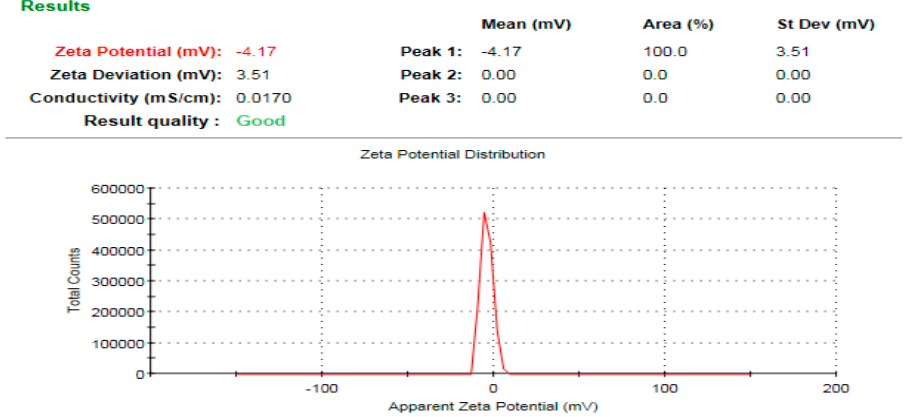
Figure 11. Surface charge of the bioprepared ZnO-NPs.